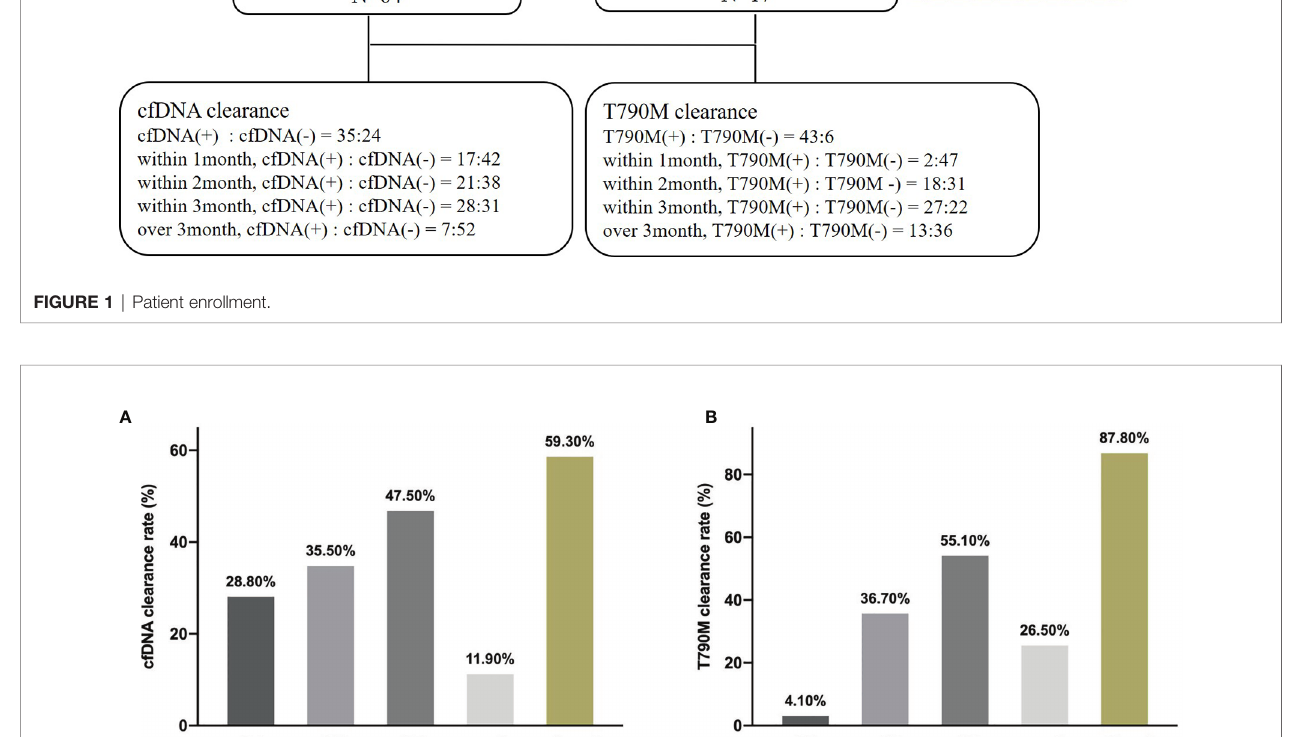
FIGURE 2 | Clearing rate of cfDNA and EGFR T790M. The clearance rate of cfDNA (A) and EGFR T790M (B) within 1month, months and more than 3months during the third generation TKIs